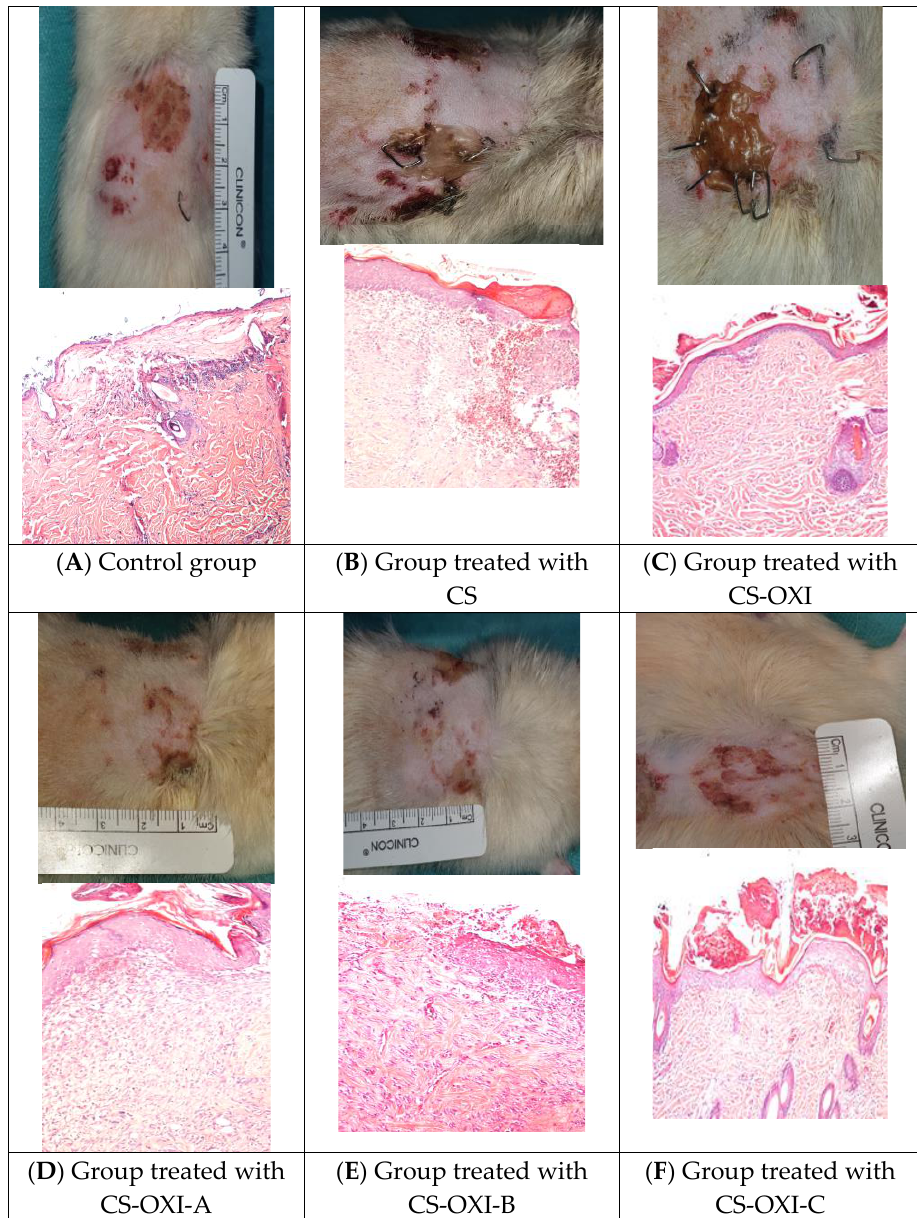
Figure 7. Microscopic and macroscopic images of burn wound at 5 days.